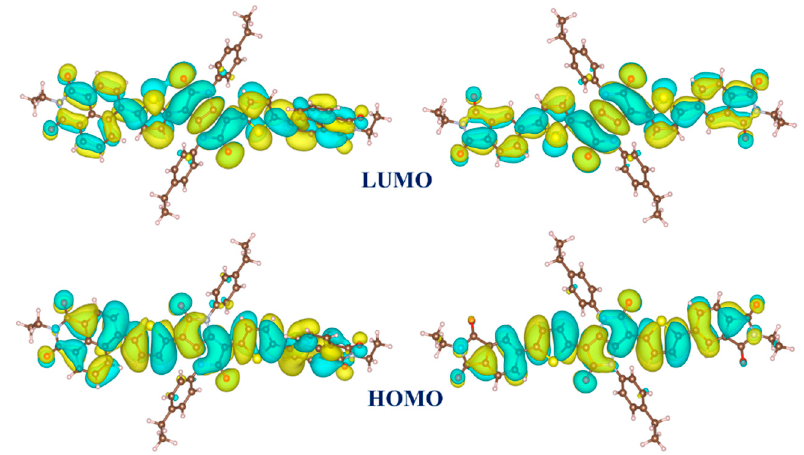
Figure 6. Comparison of calculated HOMO and LUMO orbital surfaces and energy levels of NAI-IsoDPP-NAI and PI-IsoDPP-PI using Density Functional Theory (DFT).